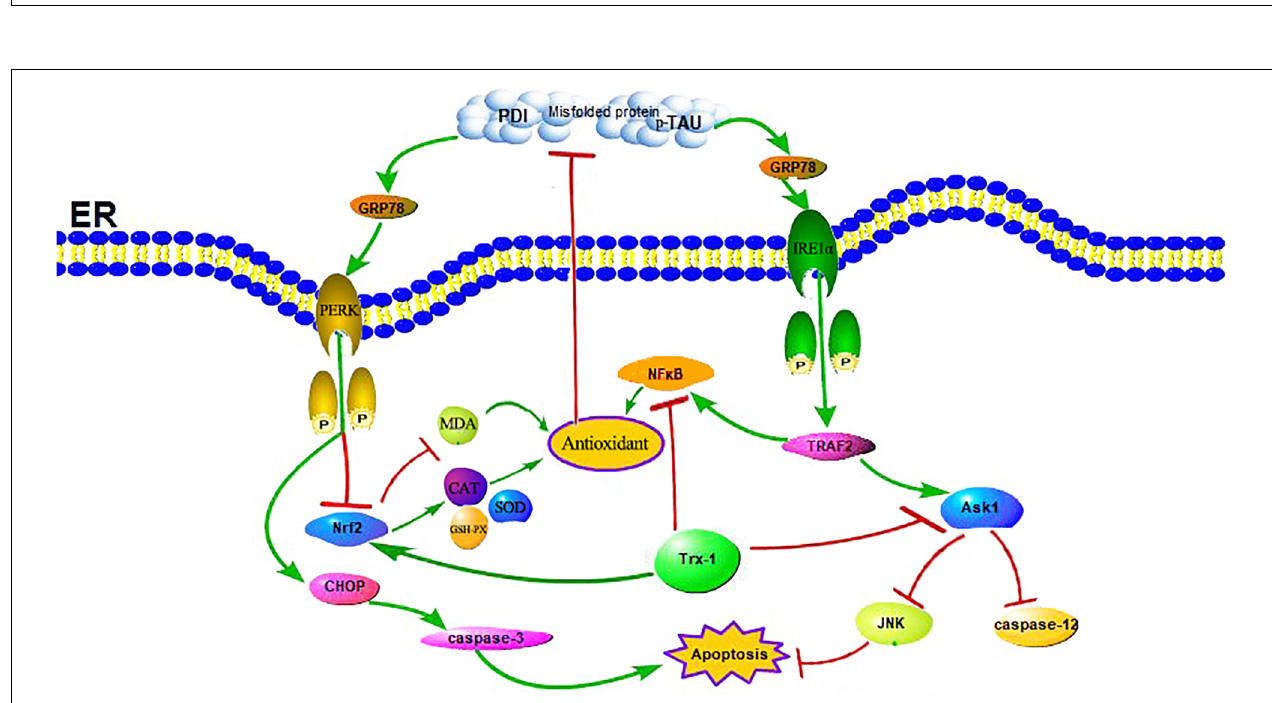
FIGURE 8 | Schematic illustration of the role of Trx-1 in regulating DM-induced ERS and OS. On the one hand, the upregulation of Trx-1 increased Nrf2 and inhibited NF κ B, leading to the increase of anti-oxidant enzymes and the decrease of oxidases to exert antioxidant stress and anti-endoplasmic reticulum stress, which reduced misfold protein production. On the other hand, the upregulation of Trx-1 inhibited ASK1 phosphorylation, decreased the expression of JNK and caspase-12, further exerted antiapoptotic effects.